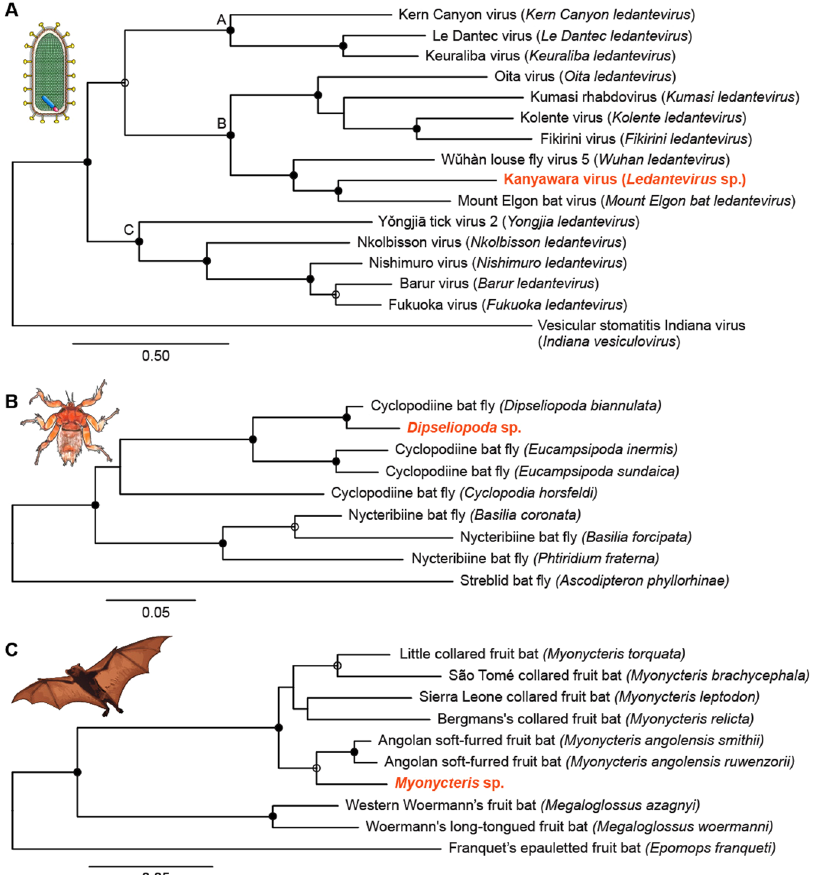
Figure 2. Maximum likelihood phylogenetic trees of rhabdoviruses ( A ), bat flies ( B ), and pteropodid bats ( C ). The rhabdovirus phylogeny is based on concatenated codon-based alignments (8,256 positions) of nucleotide sequences of the canonical rhabdovirus nucleoprotein ( N ), phosphoprotein ( P) , matrix ( M ), glycoprotein ( G ), and RNA-dependent RNA polymerase ( L ) genes of 15 viruses of the subgroups A–C of the genus Ledantevirus with vesicular stomatitis Indiana virus (genus Vesiculovirus ) as the outgroup. The bat fly phylogeny is based on concatenated codon-based alignments (876 positions) of mitochondrial cytochrome oxidase subunit II (COII) and cytochrome B (CYTB) nucleotide sequences of eight nycteribiids (subfamilies Cyclopodiinae and Nycteribiinae) with the streblid Ascodipteron phyllorhinae as the outgroup. The bat phylogeny is based on concatenated codon-based alignments (1,820 positions) of mitochondrial cytochrome C subunit I (COI) and CYTB nucleotide sequences of nine pteropodids of the subfamily Epomophorinae, with eight of them belonging to the tribe Myonycterini and Franquet’s epauletted fruit bats (tribe Epomophorini) as the outgroup. Circles on nodes indicate statistical confidence based on 1,000 bootstrap replicates of the data (closed circles = 100%; open circles ≥ 75%); scale bars indicate nucleotide substitutions per